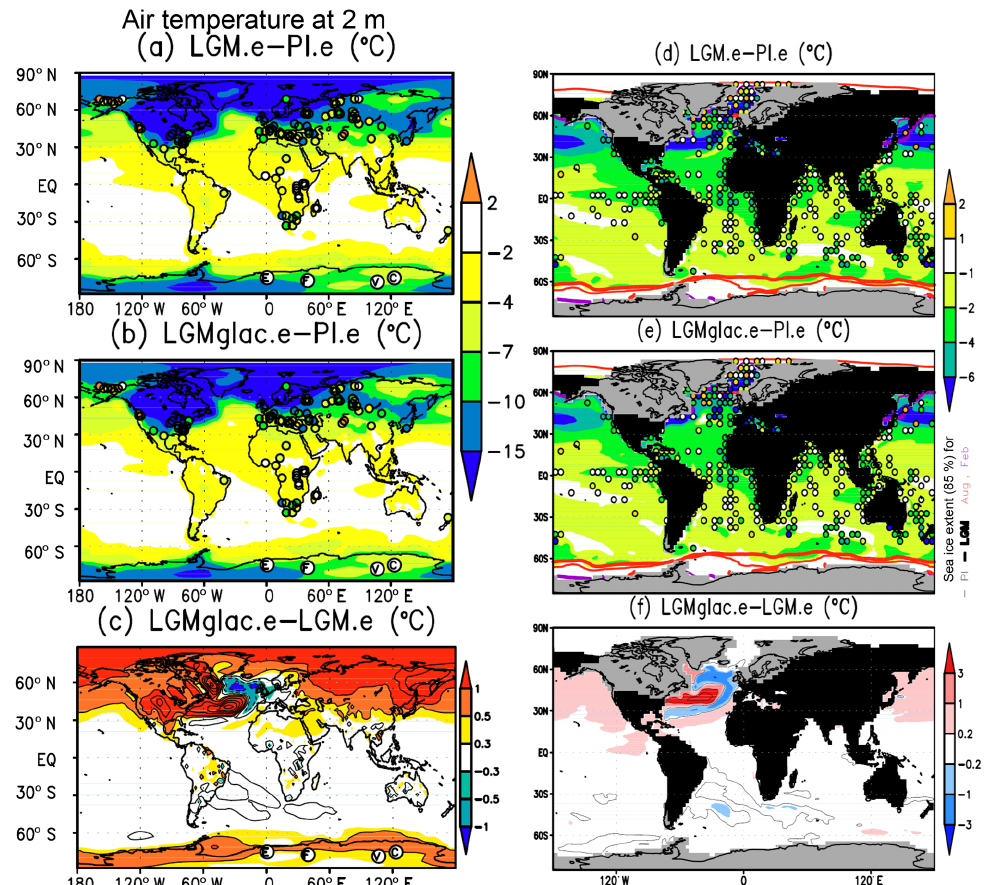
Figure 12. Difference in surface temperature at 2m of height: (a) LGM.e–PI.e, (b) LGMglac.e–PI.e, and (c) LGMglac.e–LGM.e. Coloured circles represent reconstructed temperature change by pollen proxy archives (Bartlein et al., 2011). Circled letters in Antarctica represent four ice core locations: E for EDML, F for Dome Fuji, V for Vostok, and C for Dome C. Sea surface temperature (SST) changes: (d) LGM.e–PI.e, (e) LGMglac.e–PI.e, and (f) LGMglac.e–LGM.e. Purple and red lines in (d) and (e) are 85% sea ice concentration in February and August for PI (thin) and LGM (thick), respectively. Coloured circles represent MARGO SST reconstruction (MARGO project members, 2009). Light grey represents ice sheet